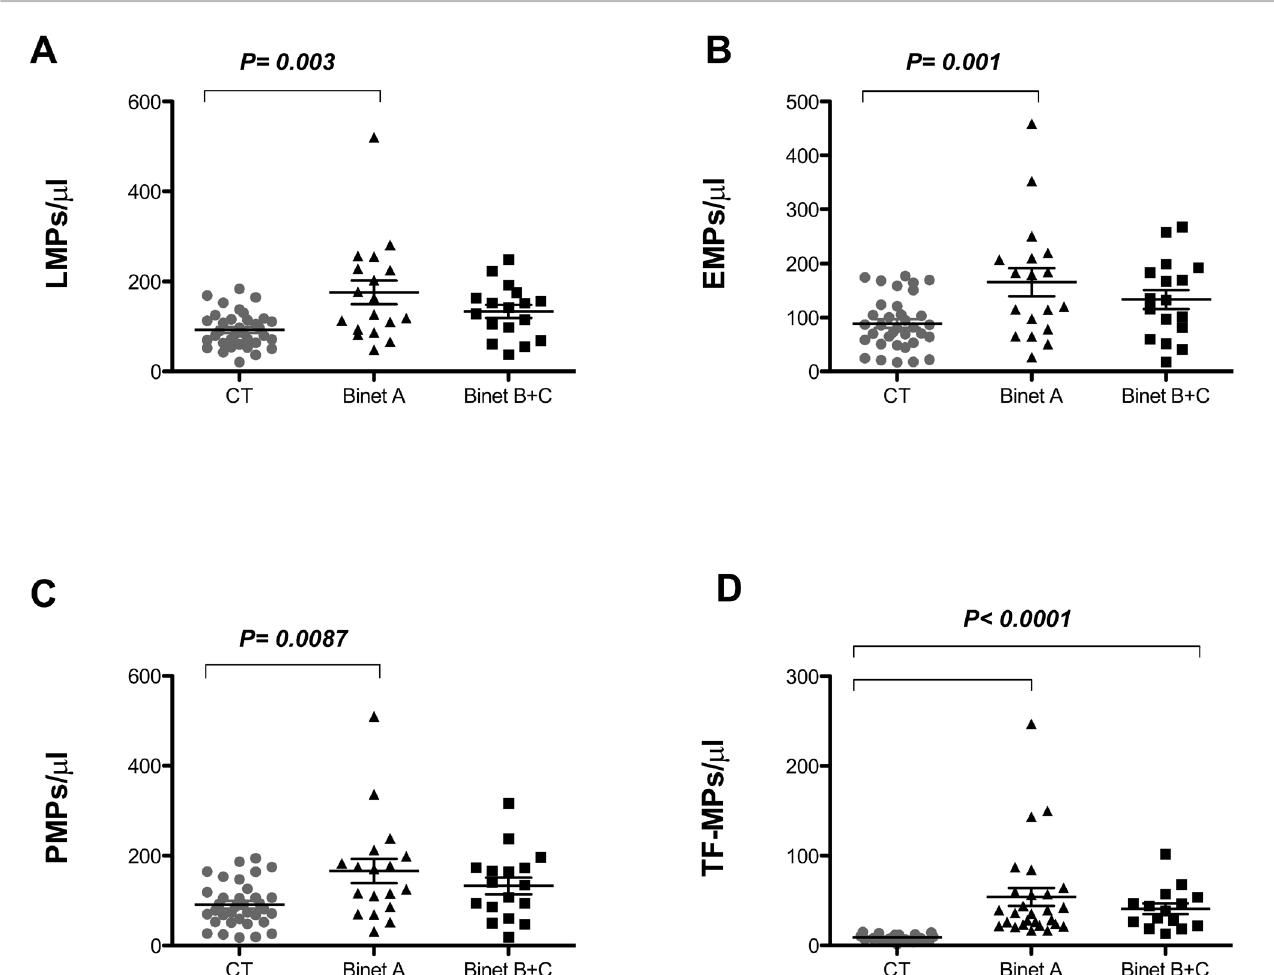
FIGURE 3 - Analysis of circulating microparticles derived from B lymphocytes (A), endothelial cells (B), platelets (C), and TF (D) in plasma samples from patients with CLL and controls (X axis), according to the staging of the disease (Binet A, B+C stages). The Y axis represents the amount of MPs/μl.